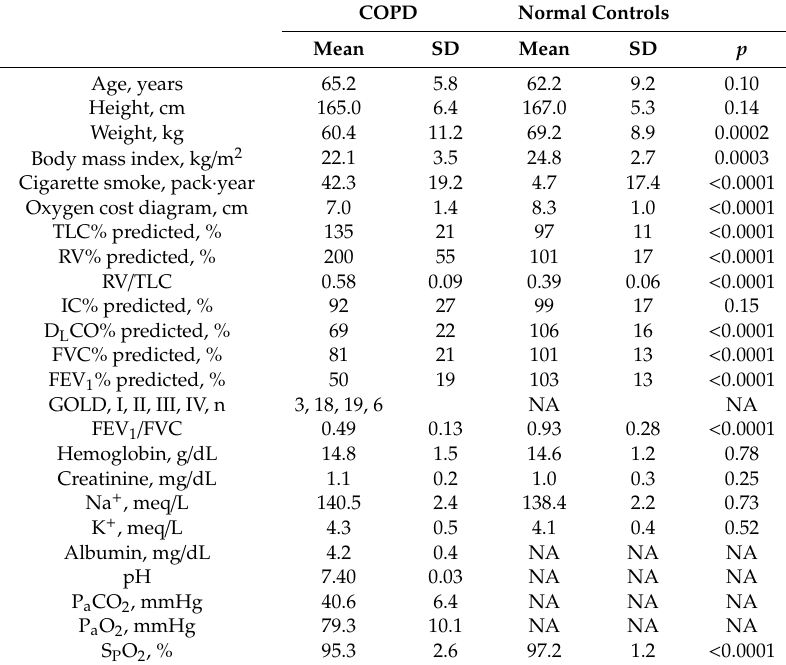
Table 1. Demographics and lung function in 80 male subjects with 46 subjects of chronic obstructive pulmonary disease (COPD) and 34 healthy